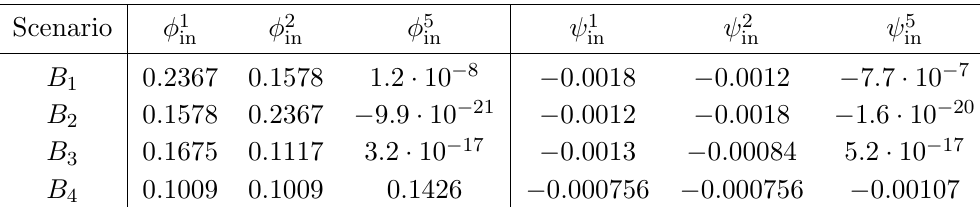
= 65 in the scenarios of type B (see e